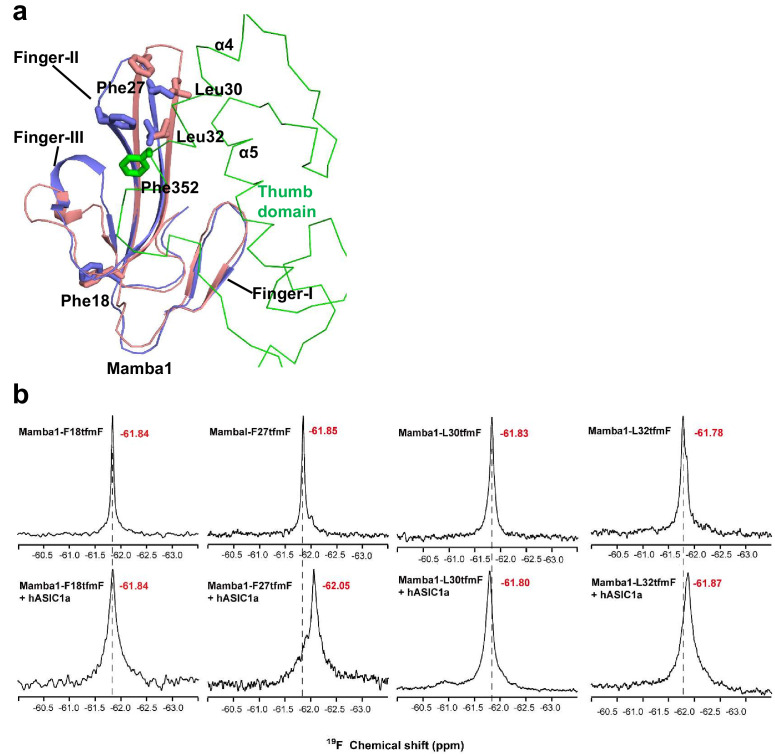
One-dimensional 19F-NMR measurements of Mamba1.(a) Structure comparison of Mamba1 in apo from (pink, PDB 5D5Z) and in complex with hASIC1a (blue), showing the conformational change of Mamba1 after binding to hASIC1a is shown. Structure comparison indicates the tip region of Finger II of Mamba1 flips to the thumb domain of hASIC1a. (b) One-dimensional 19F-NMR measurements were performed using Mamba1 with substitution of F18tfmF, F27tfmF, L30tfmF or L32tfmF in the absence or presence of hASIC1aΔC. The chemical shift for each measurement is indicated.